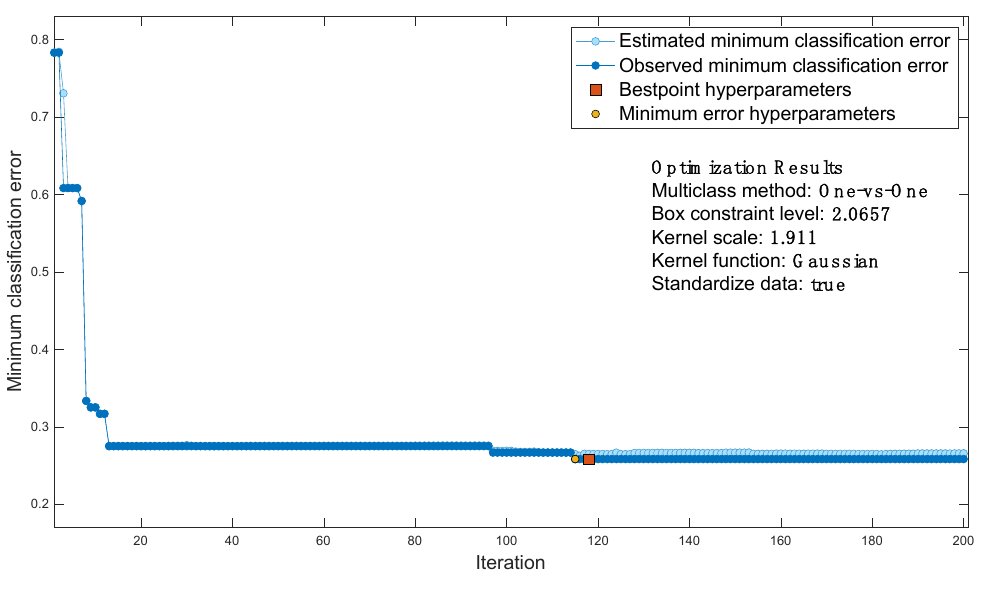
Figure 7. Classification error function.